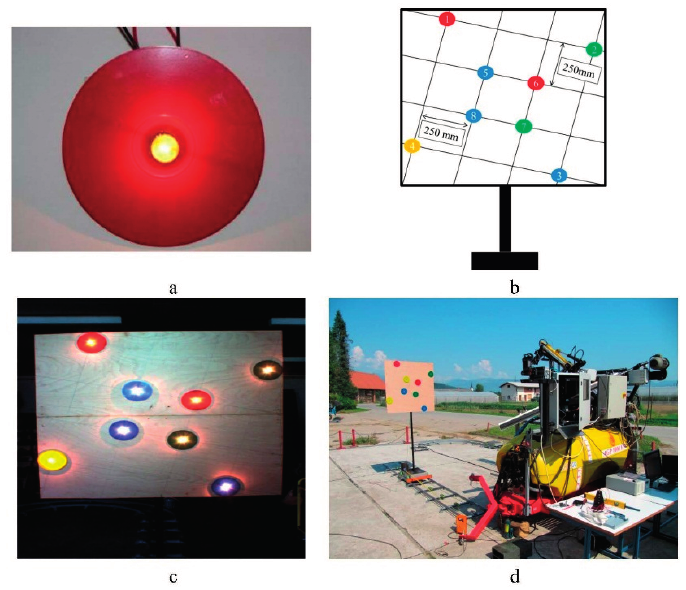
Figure 4. ACPs ( a ) single target with an incandescent light bulb in the middle; ( b ) ACPs setup; ( c ) ACPs mounting plate; ( d ) DDTM evaluation